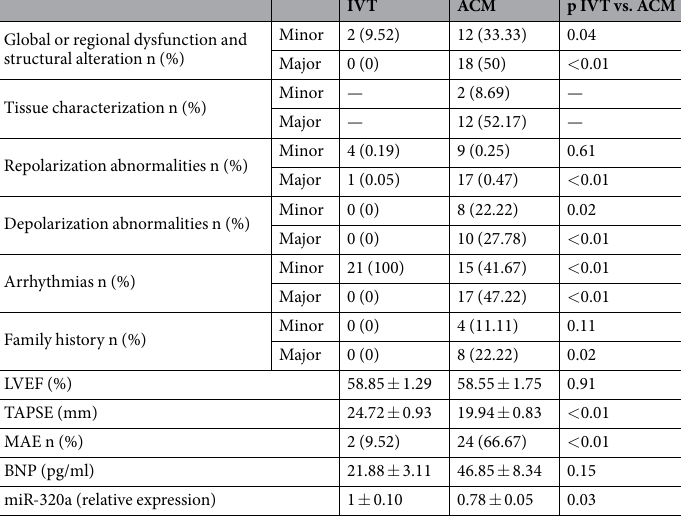
Table 2. Established Arrhythmogenic CardioMyopathy (ACM) major or minor diagnostic criteria 7 and clinical characteristics in Idiopathic Ventricular Tachycardia (IVT) vs. ACM patients. LVEF, Left Ventricular Ejection Fraction (n = 21 IVT, n = 35 ACM); TAPSE, Tricuspid Annular Plane Systolic Excursion (n = 18 IVT, n = 35 ACM); MAE, Prior Major Arrhythmic Events (n = 21 IVT, n = 36 ACM); BNP, Brain Natriuretic